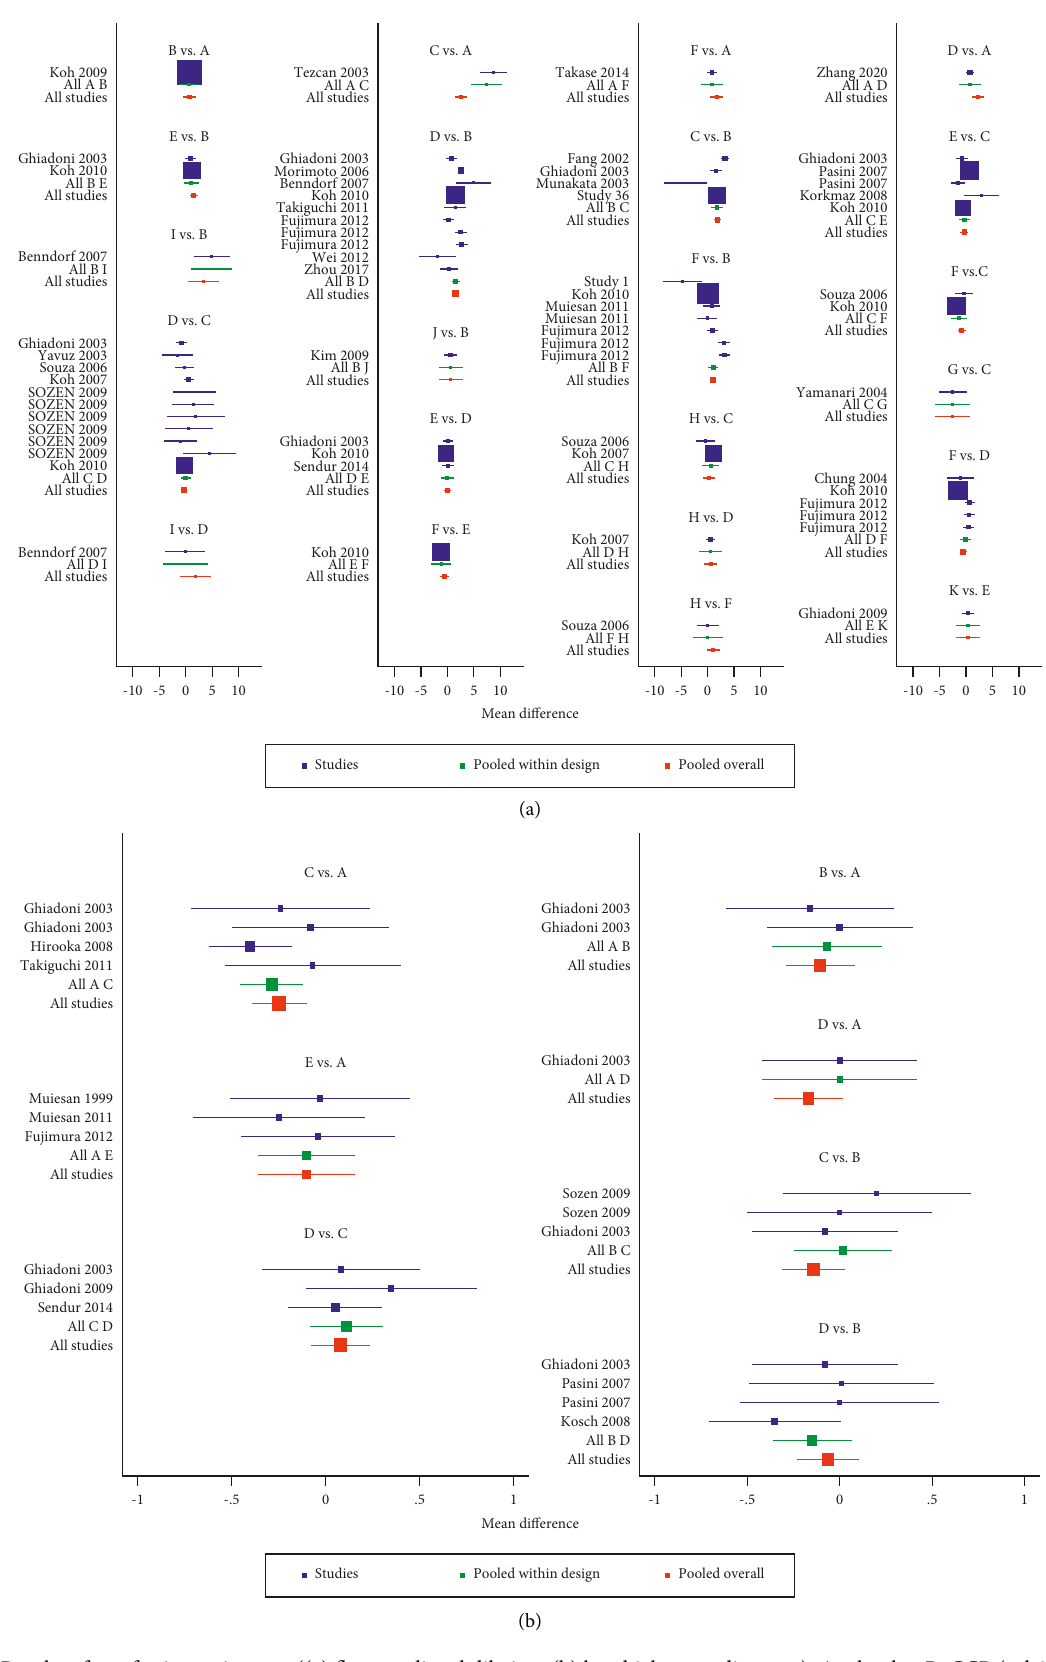
Figure 5: Results of test for inconsistency. ((a) flow-mediated dilation, (b) brachial artery diameter). A, placebo; B, CCB (calcium channel blockers); C, ACEI (angiotensin-converting enzyme inhibitors); D, ARB (angiotensin receptor blocker); E, β -blocker; F, diuretic; G, CCB + β -blocker; H, ACEI+ARB; I, ARB +CCB; G, ACEI